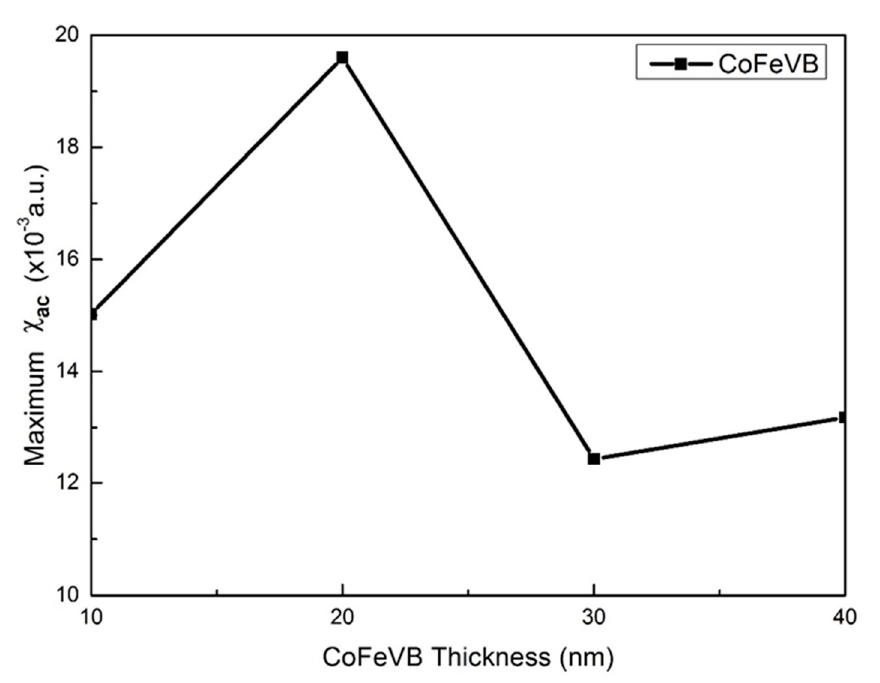
Figure 4. Maximum alternate-current magnetic susceptibility for the CoFeVB films.